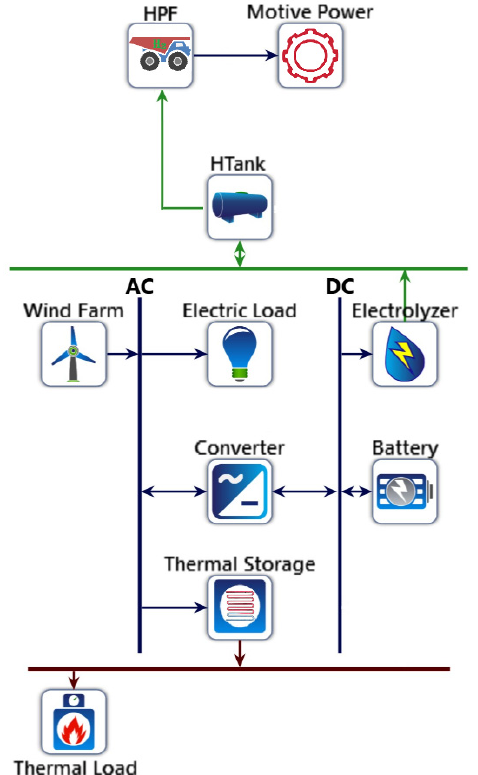
Figure 4. All-renewable system with hydrogen-powered fleet (HPF) and battery storage configura- tion.